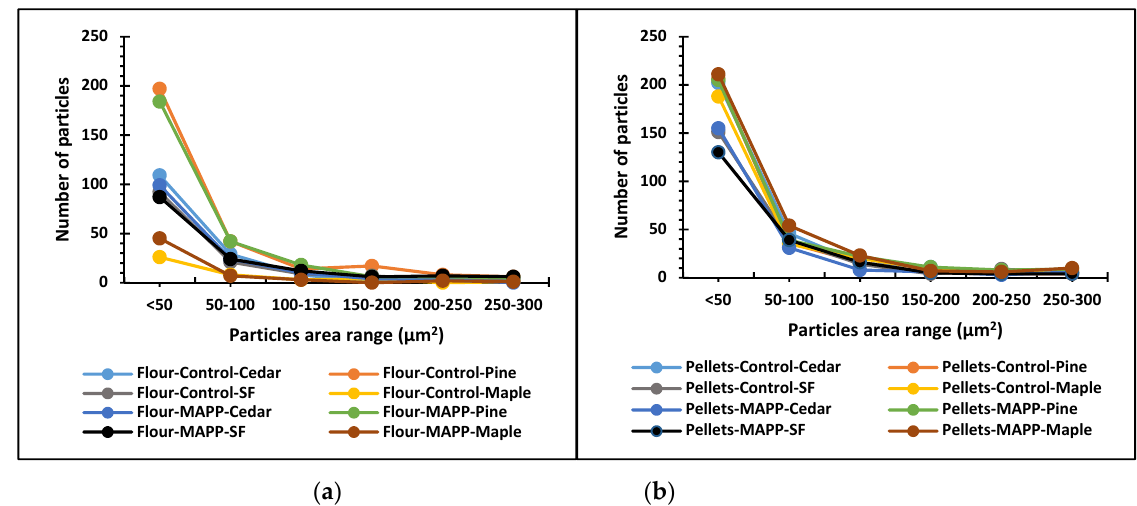
Figure 3. Area of wood particles in the polymer matrix ( a ) wood flour and ( b ) wood pellets. The average density of PP is 900 kg/m 3 . Figure 4 below shows the density of WPC samples of wood flour and pellets in different formulations. For all sample formulations, the density observed was higher than 900 kg/m 3 . For all cases, WPCs made from wood pellets with MAPP showed a higher density. The increase in density of WPCs made with wood pellets is because of ground wood pellets being denser than the wood flour used. Matuana and Stark [45] suggested that the compression of cell walls in the wood causes increase in density of the WPCs than the pure plastics. From our results, it can be indicated that the cell walls of pellets squeezed more than the flour. Similarly, in a microscopic level, the cell wall density of hardwoods and softwoods is almost similar that does not create significant differences in the density of composites. Results of three-way ANOVA showed that the p -value on the one-, or two- or three-way interaction of each variable (wood filler type, wood species, and additives condition) was greater than 0.05 in all conditions except the one-way interaction of wood filler. In the case of density, presence or absence of MAPP and wood species type or their interaction with the wood filler, does not make a notable difference. However, as explained before, filler type alone shows some significant differences as WPCs with pellets have a higher density than those with wood flour. On average, the density of WPCs for the wood flour controls was lower by 0.5% than the pellet formulations. Here, the density was 0.6% and 0.3% lower for the wood flour controls than the pellets for softwoods and hardwood, respectively. Likewise, in the wood flour–MAPP formulations, the average density was 0.6% lower than with pellet–MAPP formulations which was lower by 0.6% and 0.8% for softwoods and hardwoods